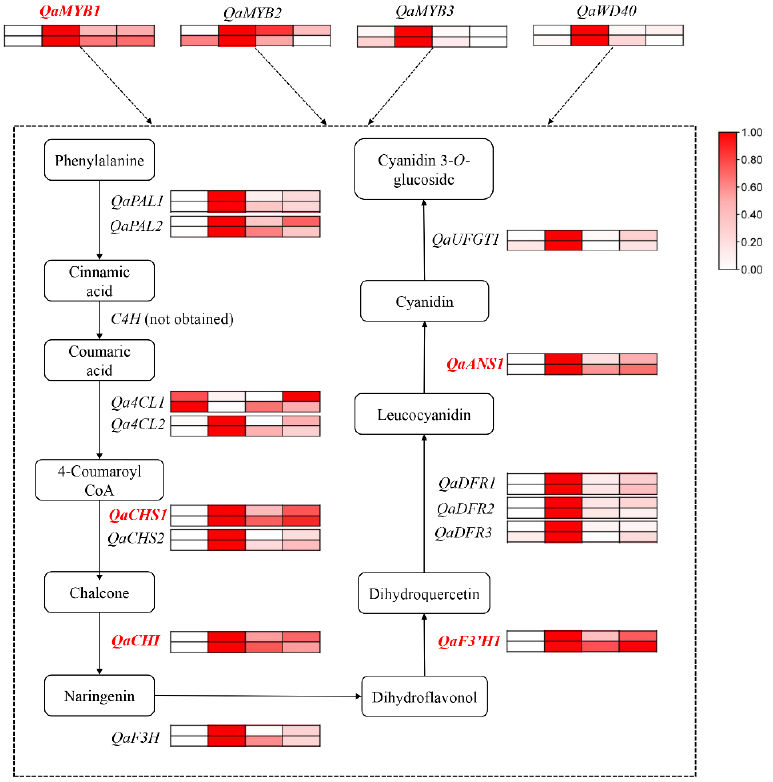
Figure 7. Regulatory network of anthocyanin synthesis in the leaves of Q. aliena . Heat maps represent the gene expression in QAC, QA1, QA2 and QA3 (left to right) at early discoloration stage (S2, the top) and main discoloration stage (S3, the bottom).